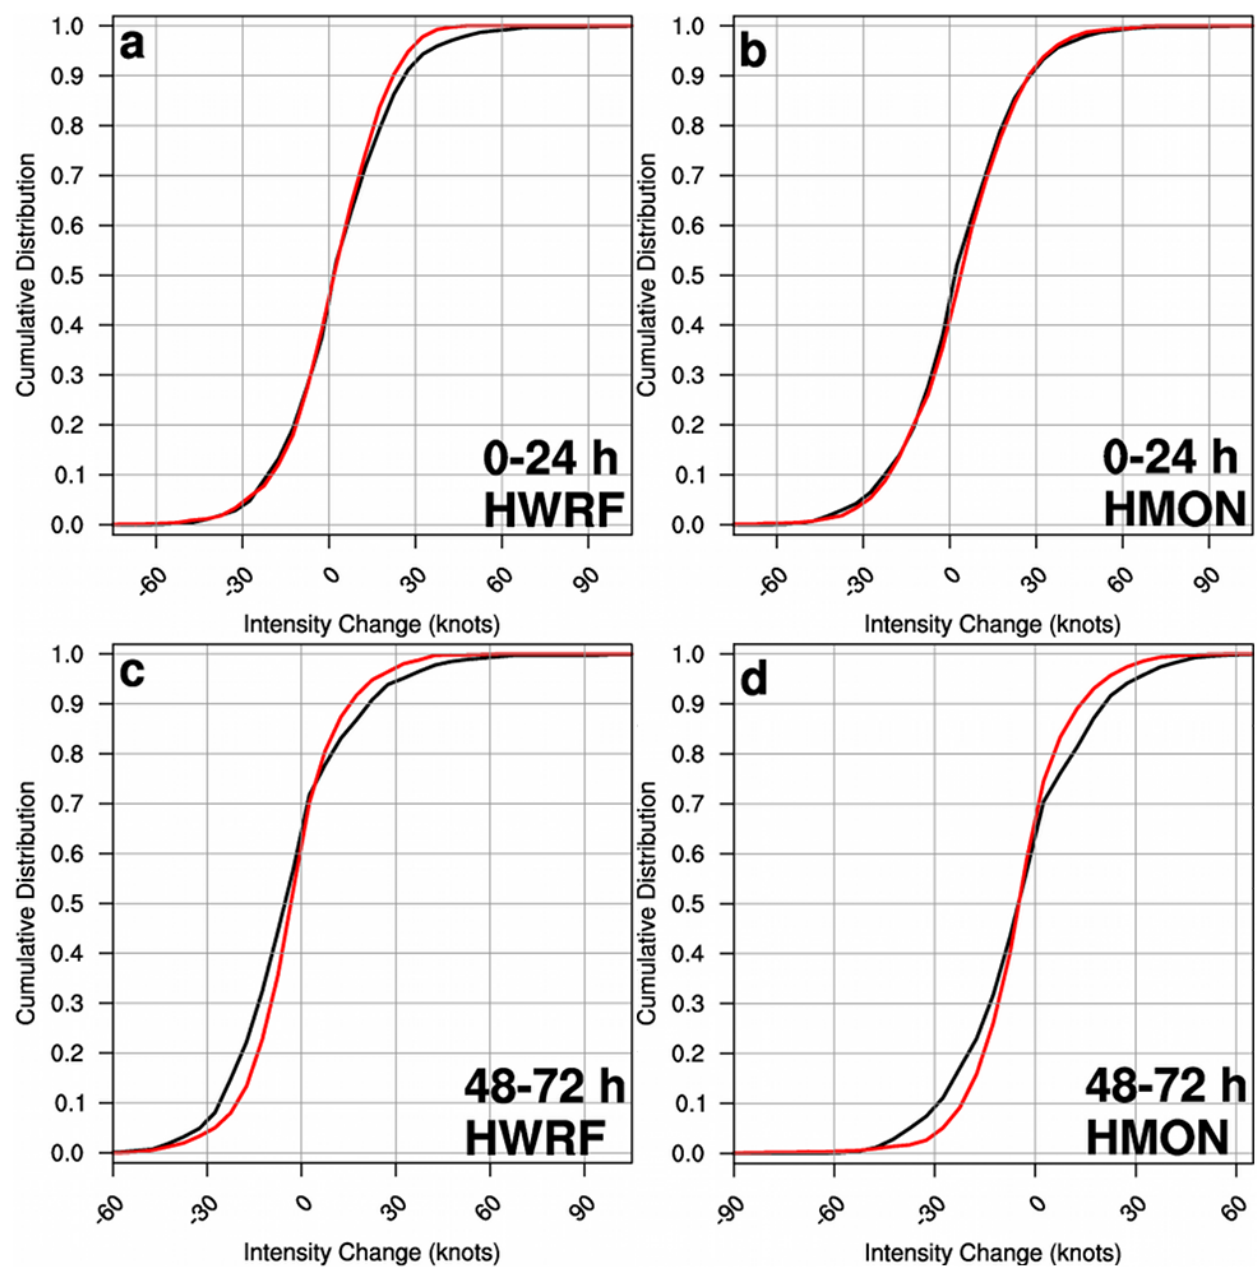
Figure 1. 0-24 h ( a ) HWRF and ( b ) HMON maximum wind speed change CDFs based on retrospective forecasts from the 2014–2016 cases (red line). The black line denotes the corresponding best track maximum wind speed change CDF. ( c , d ), as in ( a , b ), but for the 48–72 h